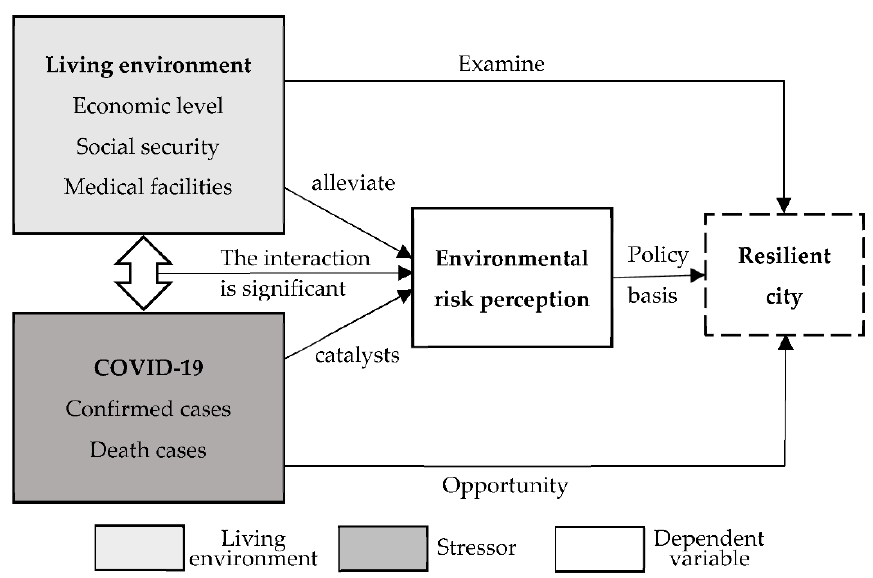
Figure 1. Analysis framework of environmental risk perception during COVID-19.